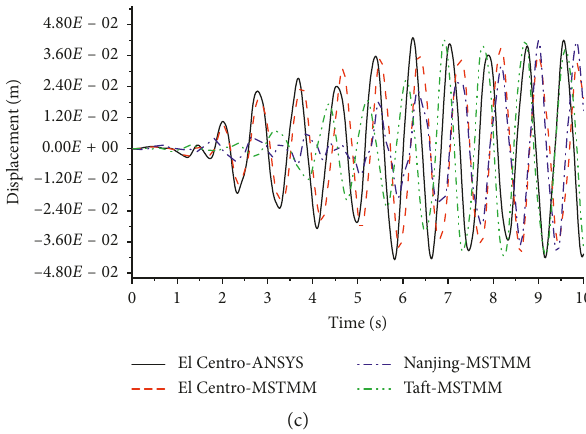
2 ). (a) 10mm, (b) 20mm, and (c)